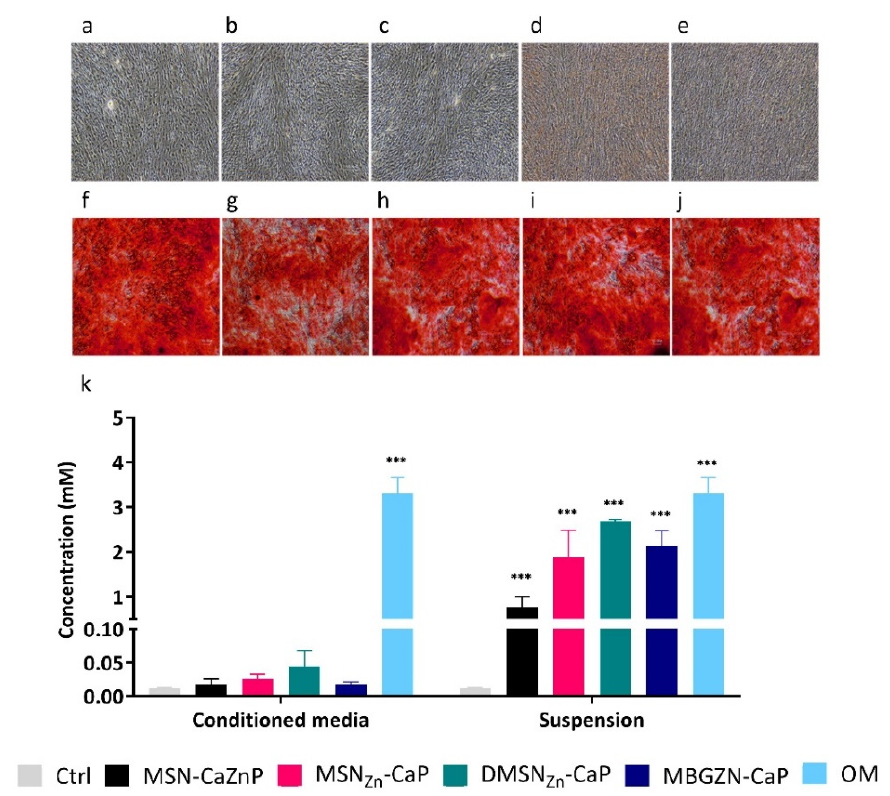
Figure 6. Calcium deposition by hMSCs at day 28 determined by Alizarin Red staining ( n = 3) when cultured in; ( a ) basic medium (Ctrl); conditioned medium of ( b ) MSN-CaZnP ( c ) MSN Zn -CaP ( d ) DMSN Zn -CaP and ( e ) MBGZn-CaP; ( f ) osteogenic medium (OM), or in medium supplemented with 70 μ g/mL ( g ) MSN-CaZnP, ( h )MSN Zn -CaP, ( i ) DMSN Zn -CaP, ( j ) MBGZn-CaP. ( k ) Quantification of calcium content at day 28. Significant differences between samples and control groups are calculated by one-way ANOVA followed by Turkey’s multiple comparison, * representing p -values as follows; *** p < 0.001.